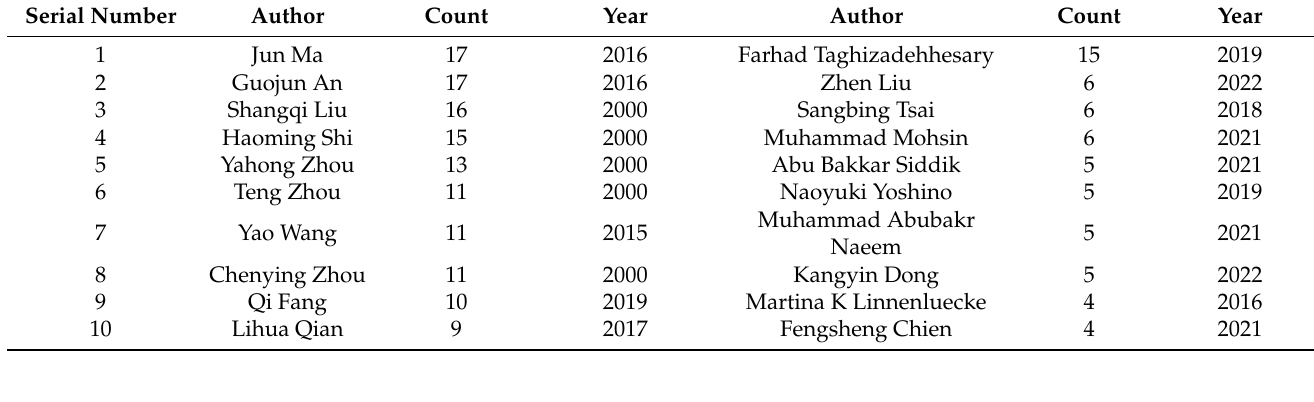
Table 1. Comparison of the number of publications by the authors (top 10).